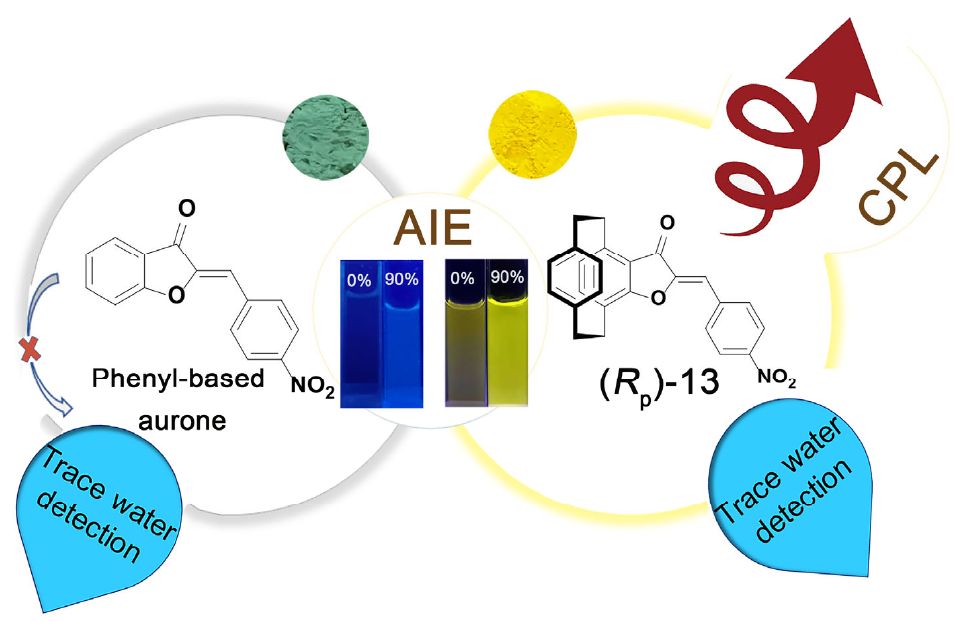
Scheme 4. Chemical structures of CPL molecules 12 − 14.